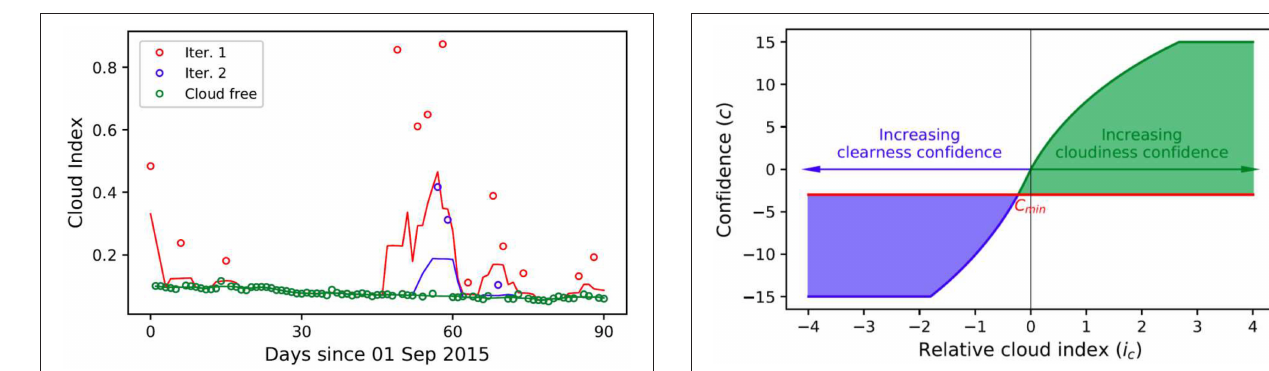
FIGURE 2 | Iterative filtering process for cloud masking. In this case three iterations were required to remove all the cloudy points. The lines are the output of Lee filtering after each iteration, and the circles indicate the points being removed at each iteration. Shown here is the case of cloud index filtering for a 3-month period and 02:00 UTC. On the figure “Iter.” denotes Iteration.